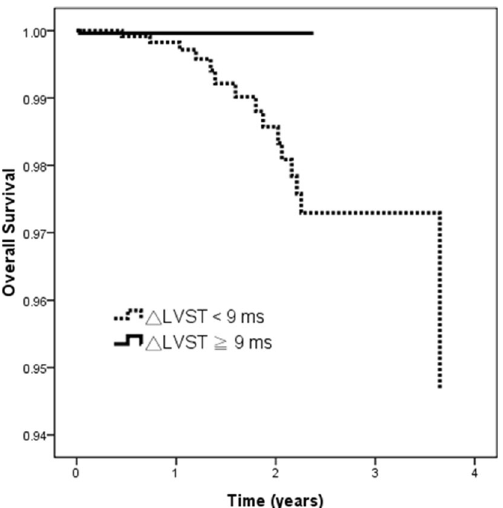
Figure 2. Adjusted overall survival curves in patients according to 75th percentile of △ LVST (9 ms). Patients with △ LVST < 9 ms had a worse overall survival than those with △ LVST ≧ 9 ms ( p = 0.015).